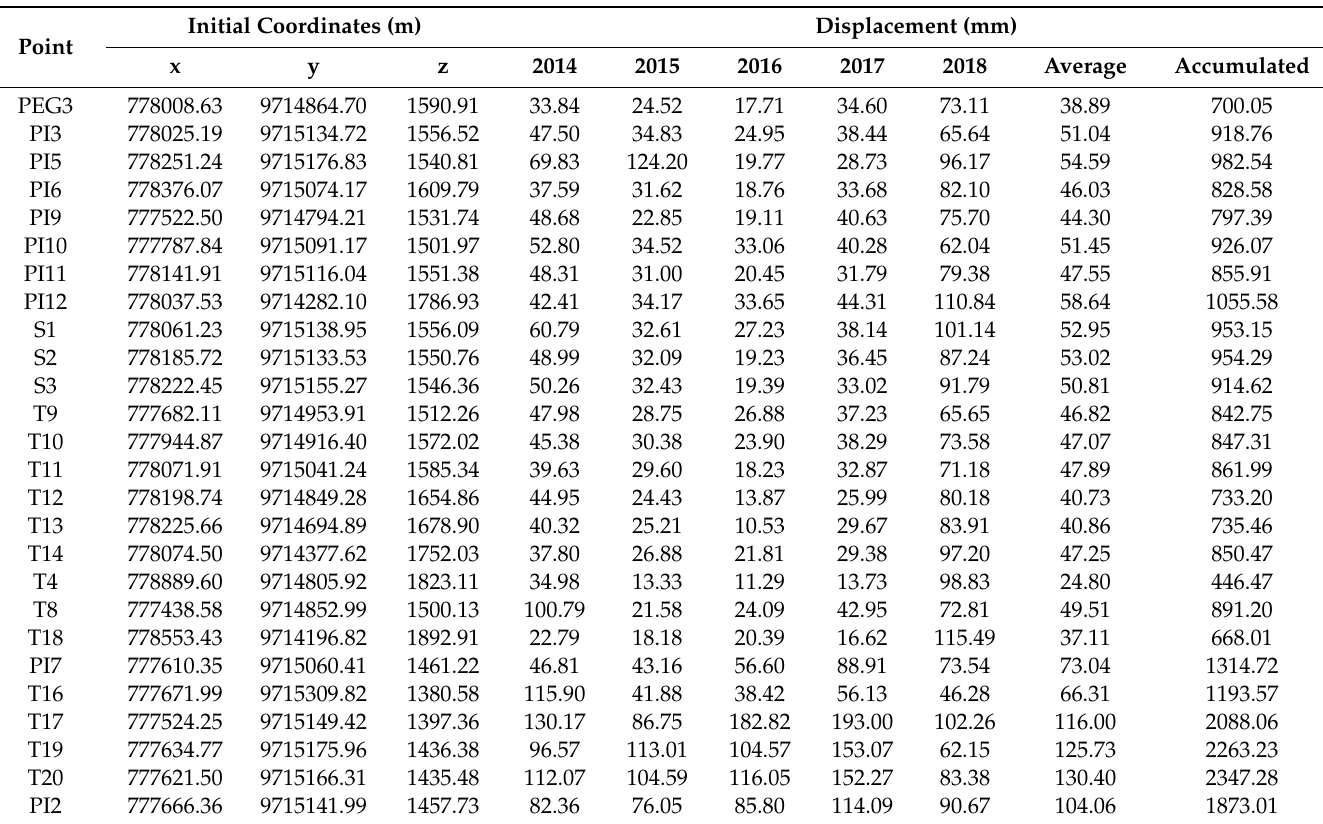
Table A2. The initial coordinates and horizontal displacement detected by 26 fixed points in Guarumales from 2014 to 2018. Initial Coordinates Point